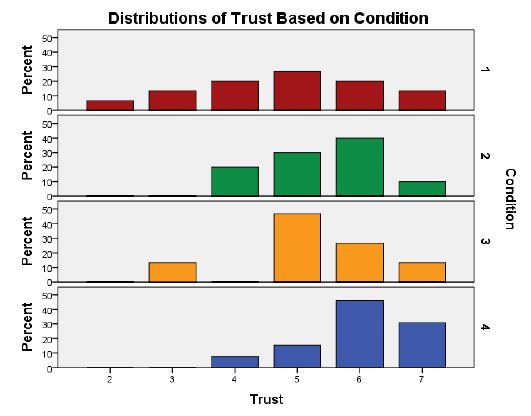
Figure 4: Distribution of participants’ evaluation of how much they trusted the robot